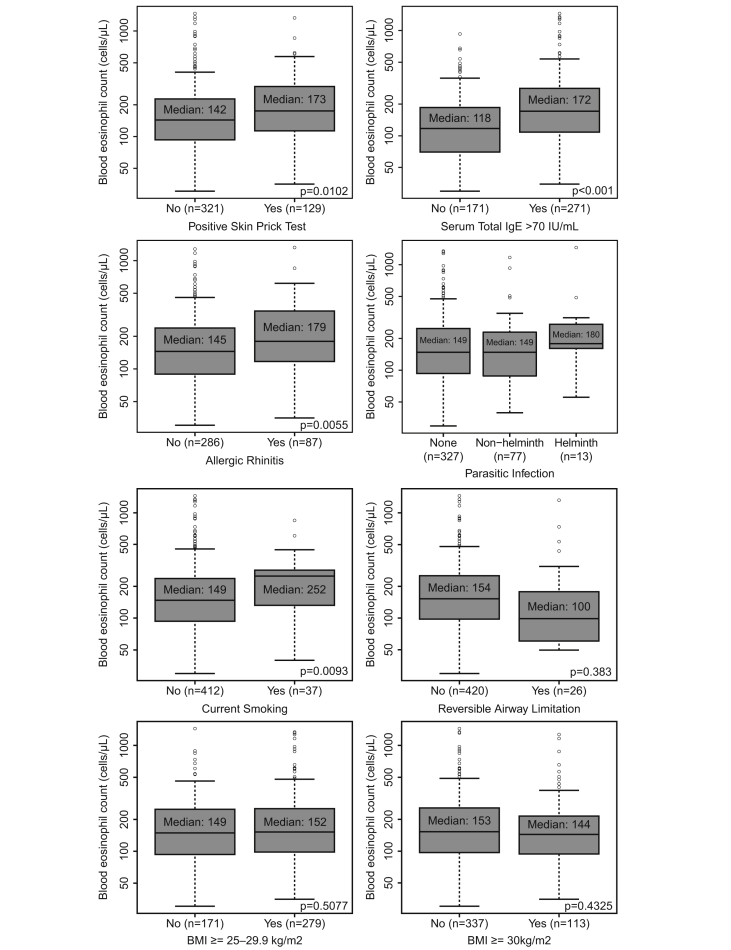
Univariate analysis of the effect of individual risk factors on log-transformed blood eosinophil counts in non-asthmatic participants. BMI, body mass index; IgE, immunoglobulin